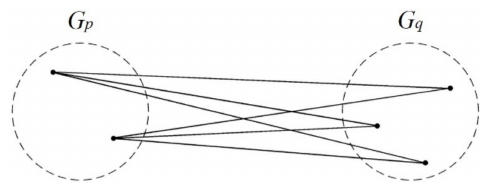
Figure 5. Conceptual diagram of the between-groups linkage.